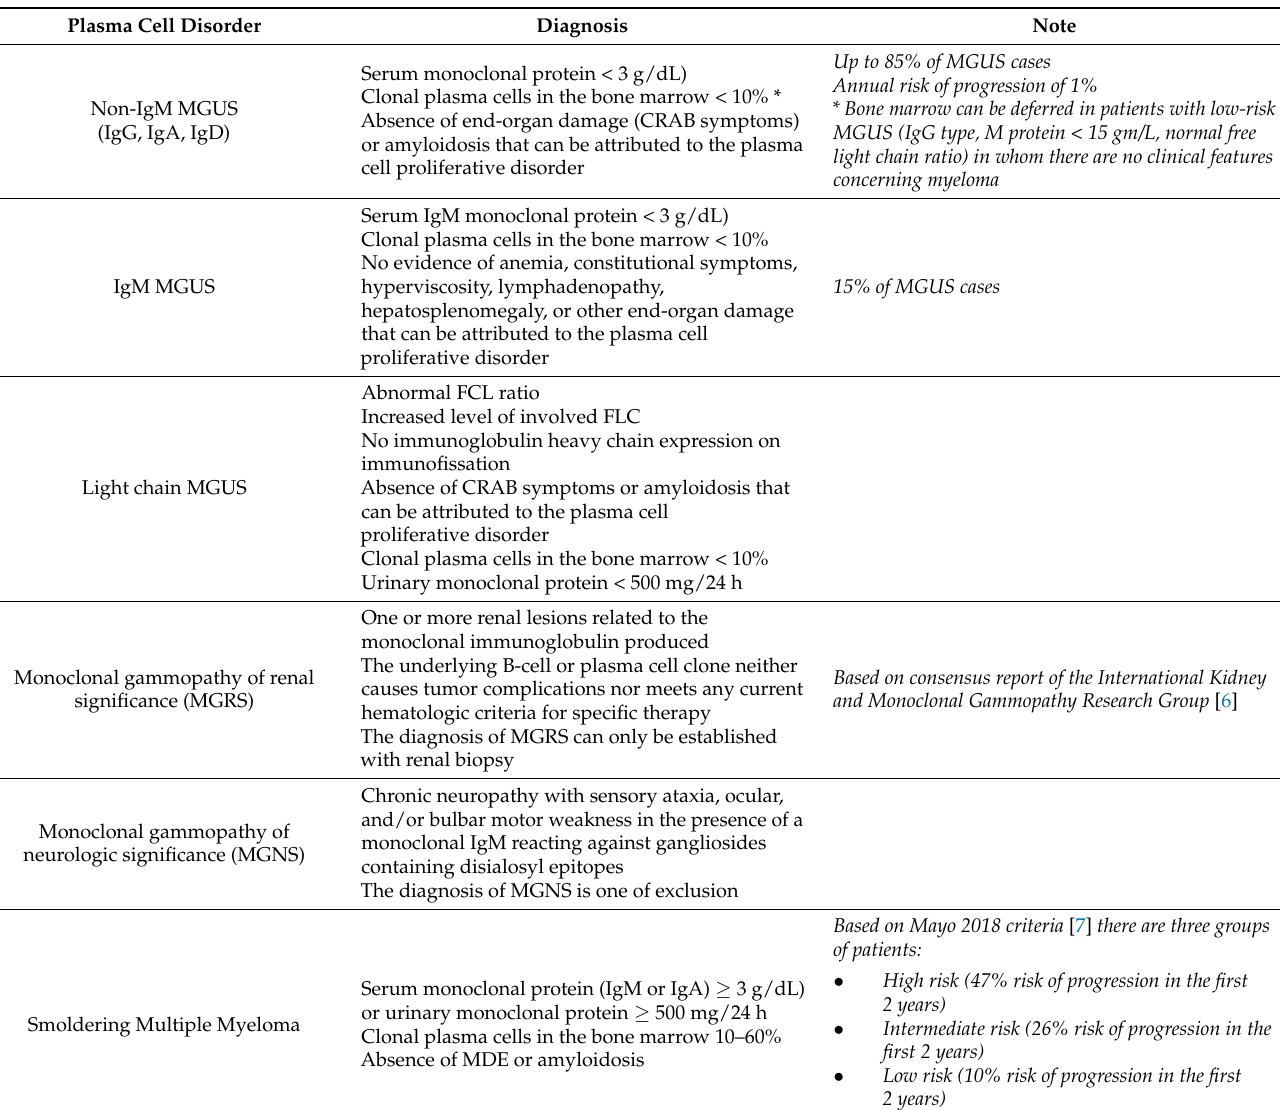
Table 1. Clinical subtypes of “premalignant” plasma cell